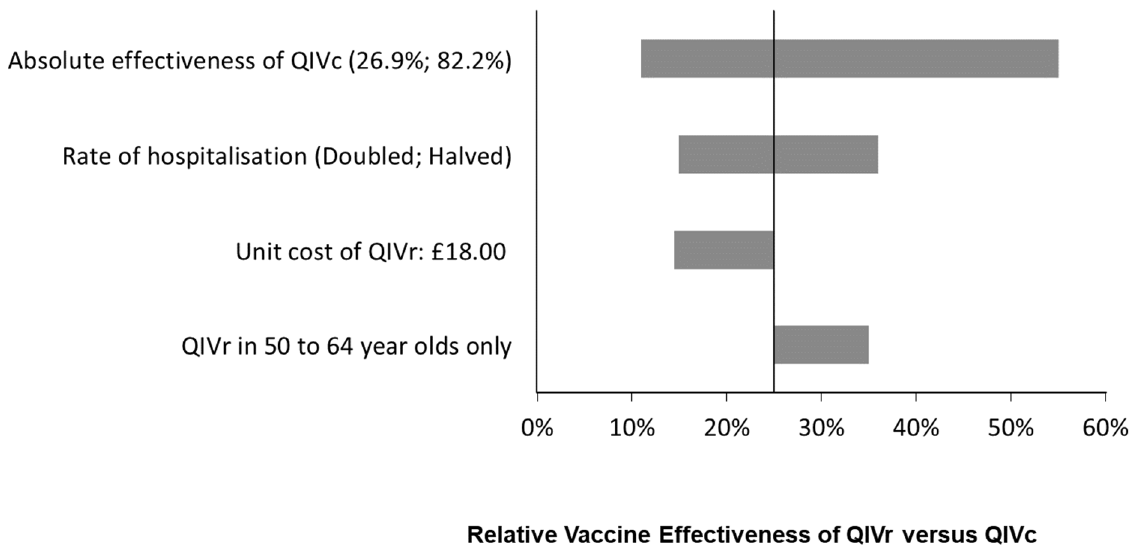
Figure 2. Tornado diagram: impact of varying key inputs on the minimum relative vaccine effectiveness of QIVr compared to QIVc required to achieve a cost per QALY gained of £20,000 or lower.